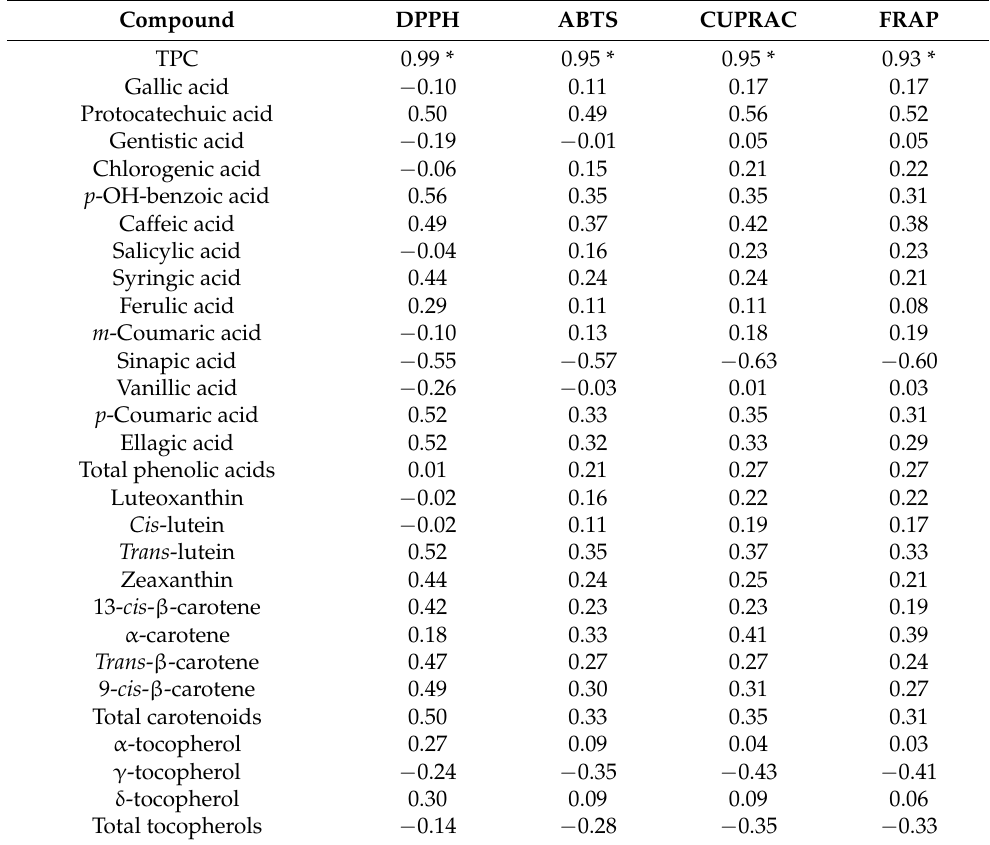
Table 7. Correlation coefficients (r) between antioxidant capacity determined by different analytical methods, total phenolics, phenolic acids, carotenoids and tocopherols in the investigated chocolates.